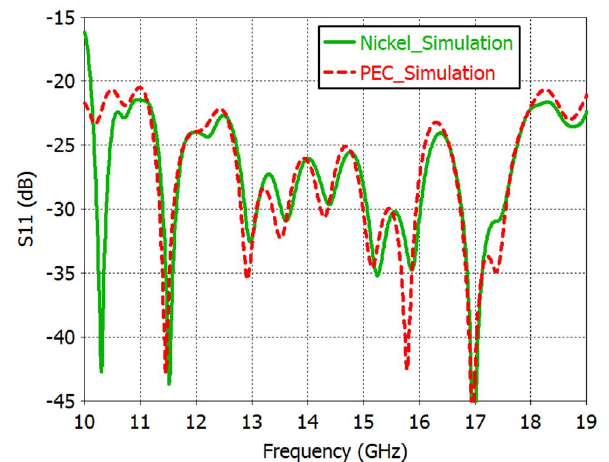
Figure 3: The simulation results for S 11 (reflection coefficient) of the proposed antennas with PLA/nickel materials and PEC